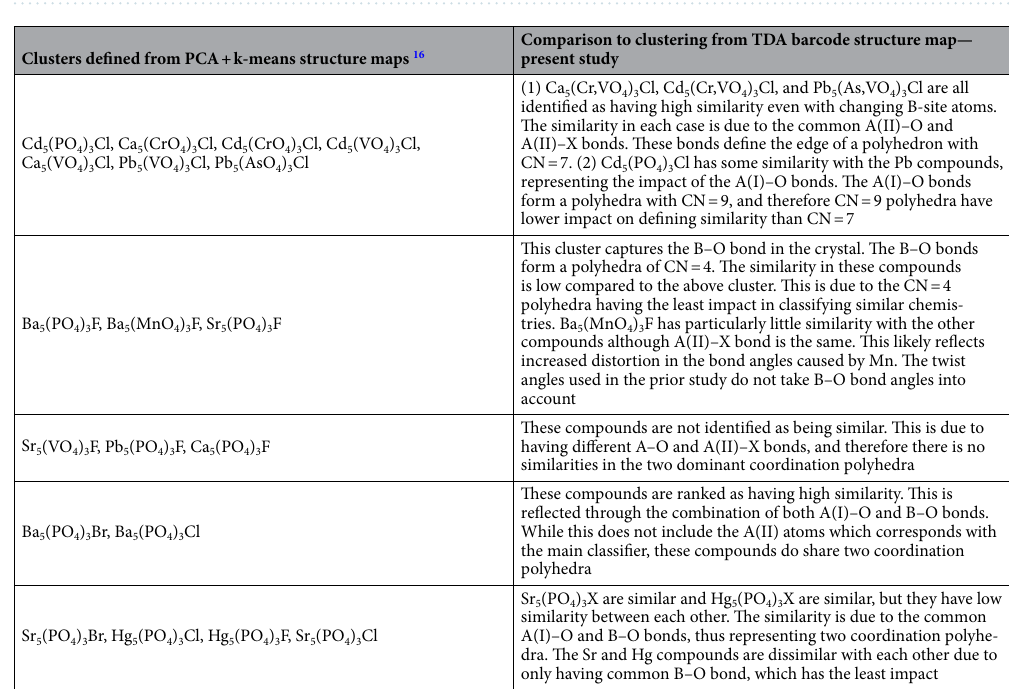
Table 3. A summary of some of the key new genres of crystal chemistry metrics uncovered by TDA to provide a higher level of granularity and more insight to define similarity between different apatite chemistries.